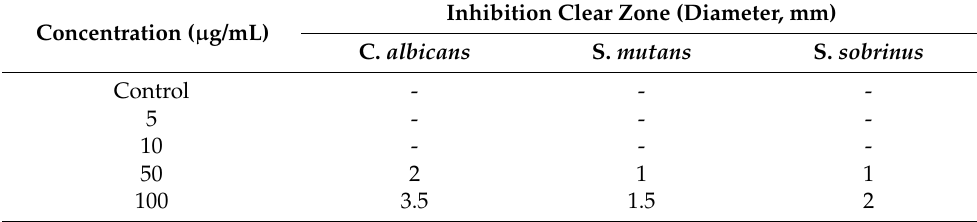
Figure 5. Antibacterial activity of propolis-embedded nanocomposites against various bacteria. Table 2. Comparison of inhibition zone estimated from Figure